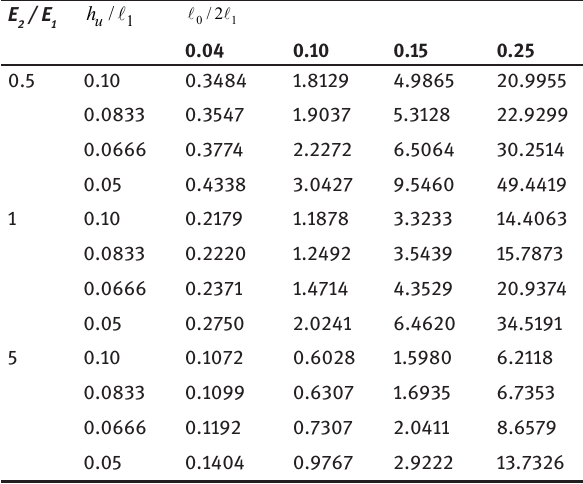
Table 4: The influence of the ratio 2 1 / E E and 1 / u